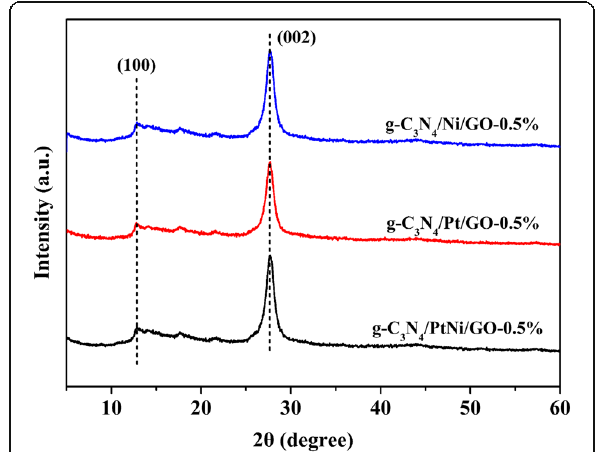
Fig. 1 The XRD patterns of g-C 3 N 4 /Ni/GO-0.5%, g-C 3 N 4 /Pt/GO-0.5%, and g-C